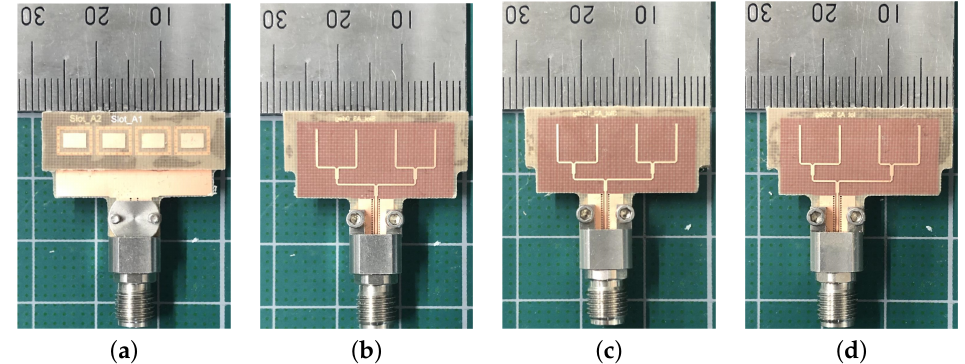
Figure 5. Geometry of the proposed 4 × 1 linear array antenna with power dividers according to the beam-steering angles: ( a ) top view, ( b ) θ 0 = 0 ◦ , ( c ) θ 0 = 15 ◦ , and ( d ) θ 0 = 30 ◦ .